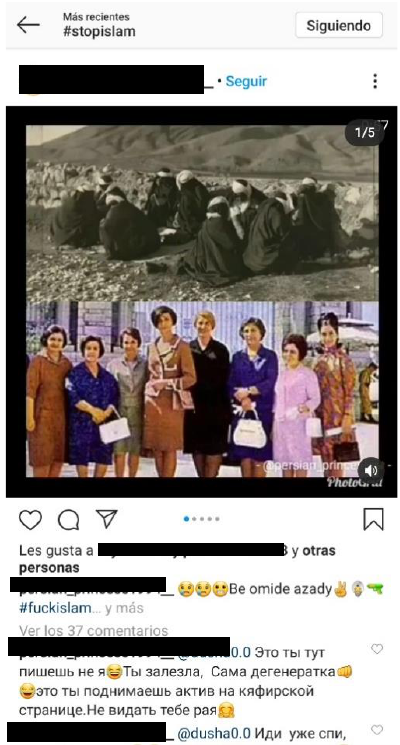
Figure 6. Examples from the category Muslim women are a security threat.